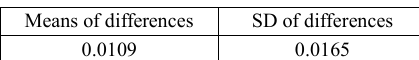
Fig. 11 Torque characteristics in master–slave